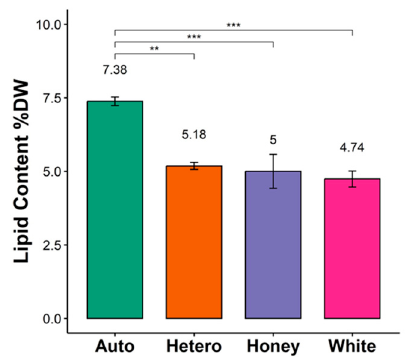
Figure 1. Lipid content of the four C. vulgaris strains (C-Auto, C-Hetero, C-Honey, and C-White) expressed in percentage % of biomass. Data represented as means ± standard deviation (SD), n = 5.